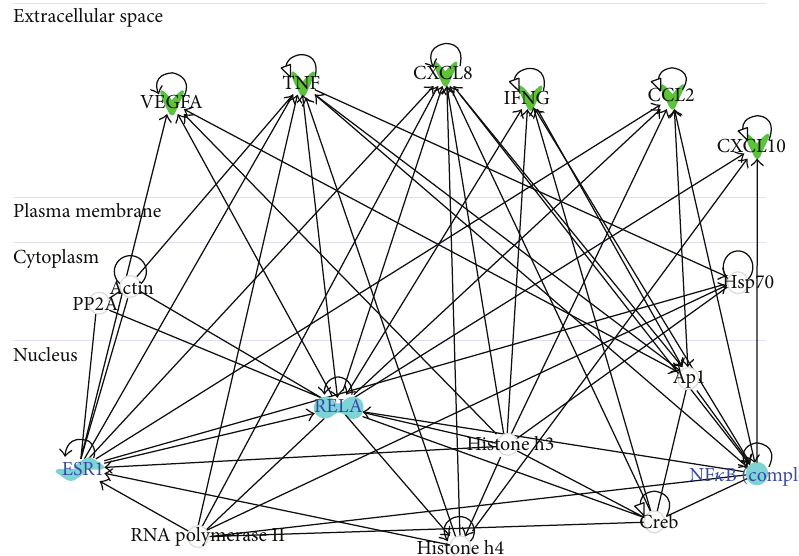
Figure 4: Interactomic analysis by ingenuity pathway analysis (IPA) of significant molecules. The interactome shows the close functional association between significant cytokines (indicated with green symbols) as well as the paths in which other functionally relevant molecules are also involved (indicated with white symbols). In detail, the cytokines reported are CXCL8 (C-X-C motif ligand 8), CCL2 (C-C motif ligand 2), VEGF (vascular endothelial growth factor), IFNG (interferon gamma), CXCL10 (C-X-C motif ligand 10), and TNF (tumor necrosis factor alpha). Moreover, three HUB nodes such as ESR1 (estrogen receptor 1), NF- 𝜅 B (nuclear factor kappa B), and RELA (v-rel avian reticuloendotheliosis viral oncogene homolog A) subunits are indicated by cyan